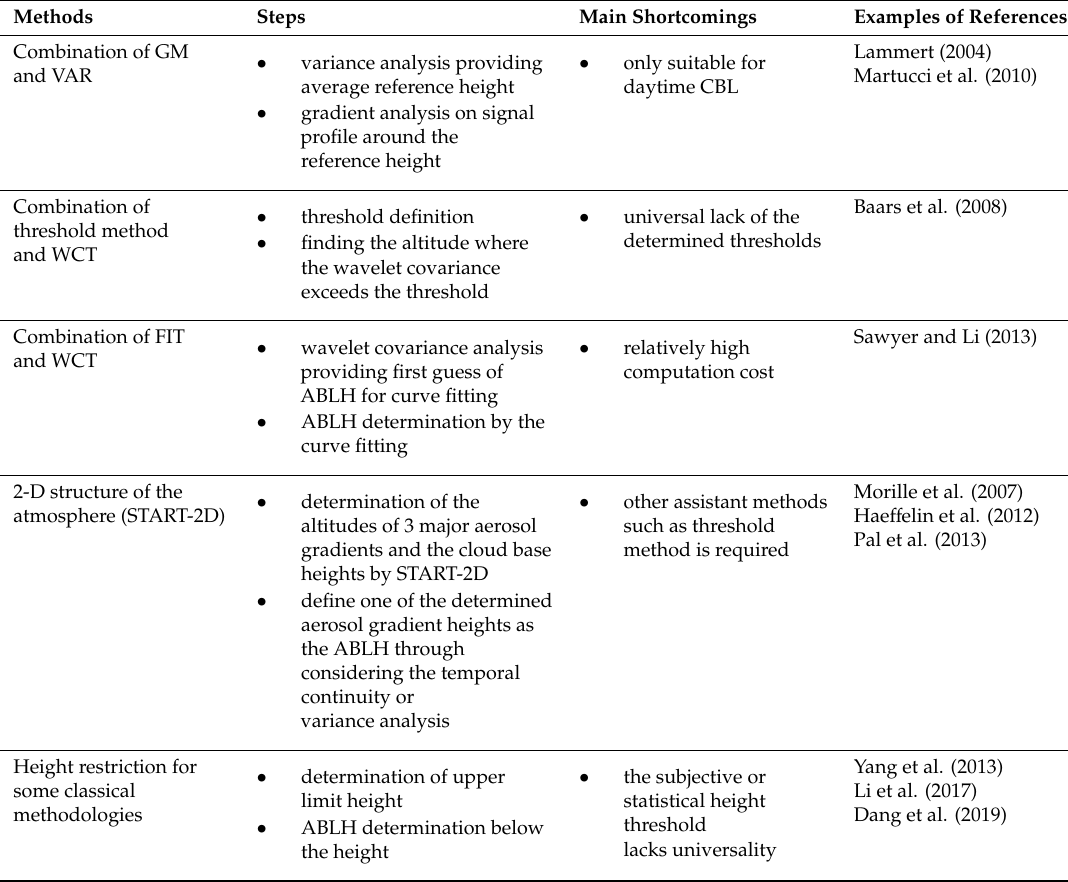
Table 3. Improved versions of some classical methodologies in Table 2 (GM, gradient method; VAR, variance analysis; WCT, wavelet covariance transform; FIT, ideal profile